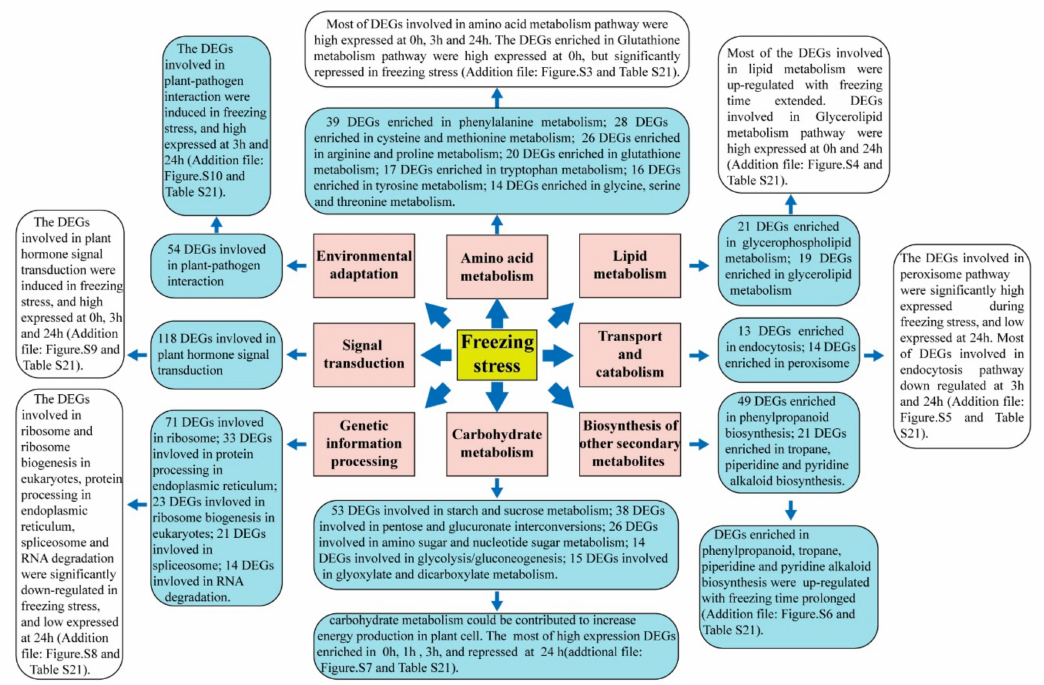
Figure 8. The differential responses of Brassica napus in response to freezing stress in transcriptome changes.